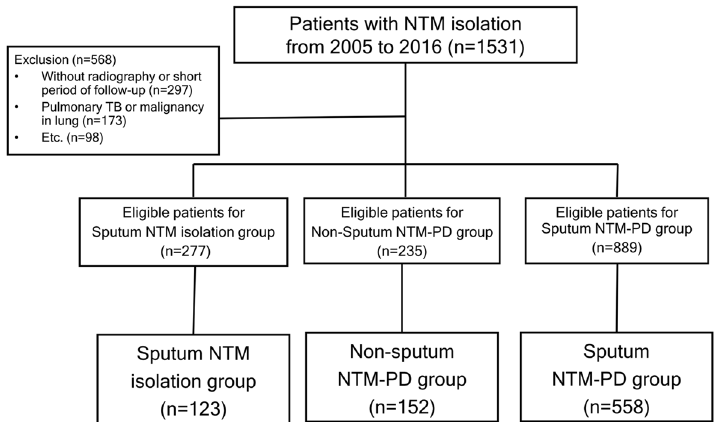
Figure 1. Flow diagram of the study population enrolled from NTM cohort at Seoul National University Bundang Hospital, from January 2005 to December 2016. NTM nontuberculous mycobacterium, NTM-PD nontuberculous mycobacterial pulmonary disease, TB tuberculosis. Patients with a single NTM isolation from sputum were designated as the sputum NTM isolation group, patients with positive results from bronchoscopic [e.g., bronchial washing or bronchoalveolar lavage (BAL)] or lung tissue specimens were designated as the NTM-PD group diagnosed using other methods (non-sputum NTM-PD group) and patients with NTM